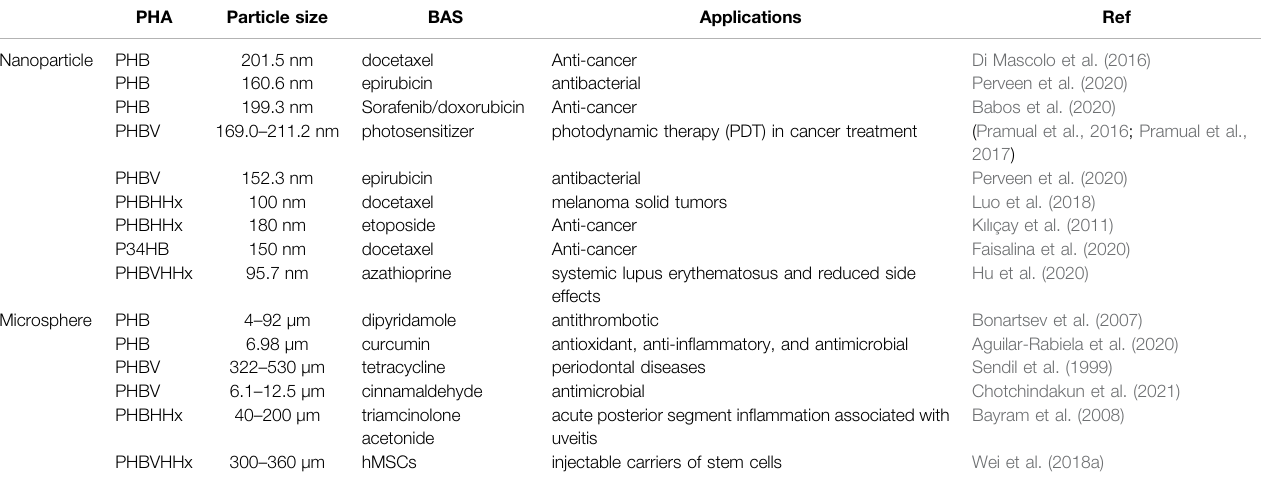
TABLE 3 | Applications of PHA-based particles including micro-/nanoparticles and